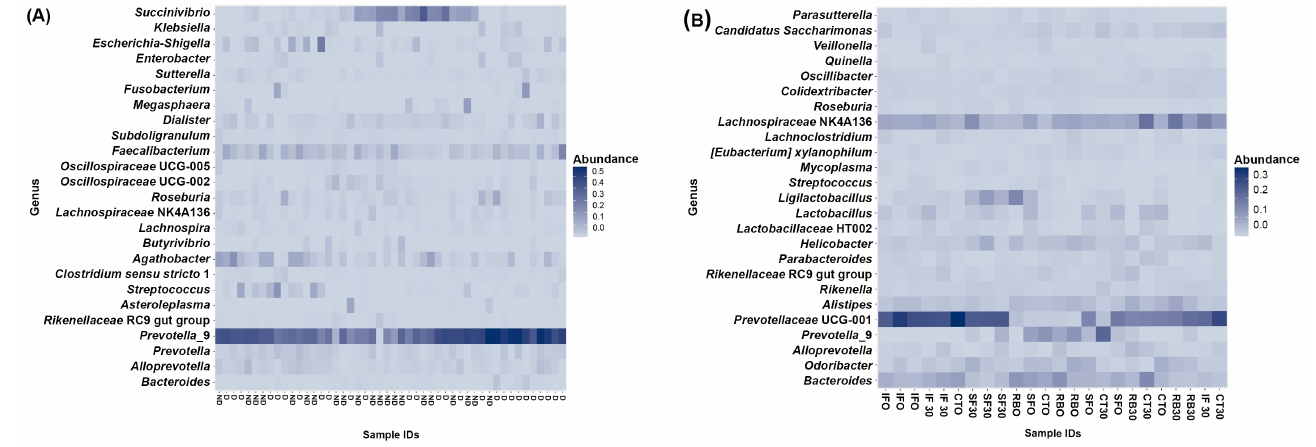
Figure 1. Heat map showing the abundance of 25 bacterial genera in ( A ) human and ( B ) mouse fecal samples. Dark and light blue gradients represent high and low abundances of bacteria, respectively (CT = control, RB = rice beverage, IF = insoluble fraction, SF = soluble fraction, D = drinkers and ND = nondrinkers. Digits (0 and 30) suffixed at the end of mouse samples denote days of treatment). A comparison between drinkers and nondrinkers revealed changes in 20 bacterial genera in humans (Table 1). An increased abundance of bacterial genera: Odoribacter , Copro- coccus , Defluviitaleaceae UCG-011, Oscillospiraceae UCG-005, Rikenellaceae RC9, Succinivibrio , Eubacterium siraeum , Oscillospiraceae UCG-002, Ruminococcus , Lachnospiraceae NK4A136, Lachnospiraceae NC2004, Butyrivibrio, Butyricimonas , Bilophila , Senegalimassilia and Anaerovo- racaceae . Family XIII UCG-001 increased, whereas a decrease in Christensenellaceae R-7, Aeromonas , Lachnoclostridium and Rothia was